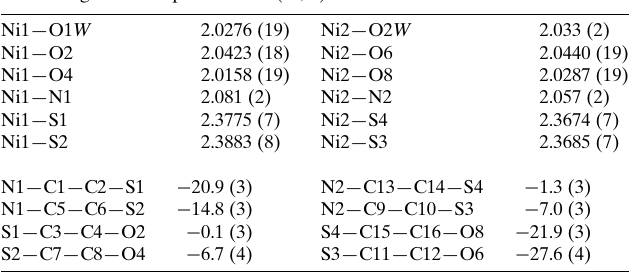
Table 1 Selected geometric parameters (A˚ , (cid:5) ).